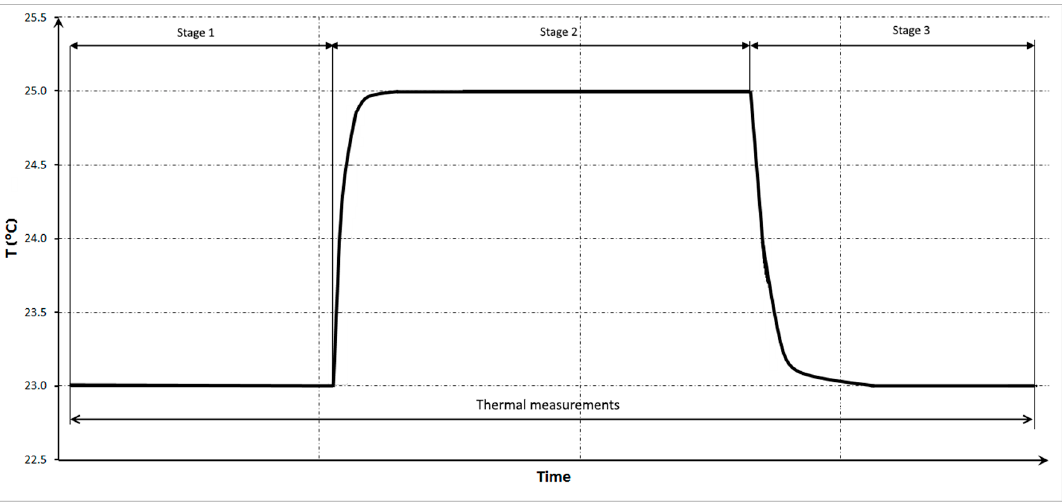
Figure 3. Schematic diagram of the applied test stand.